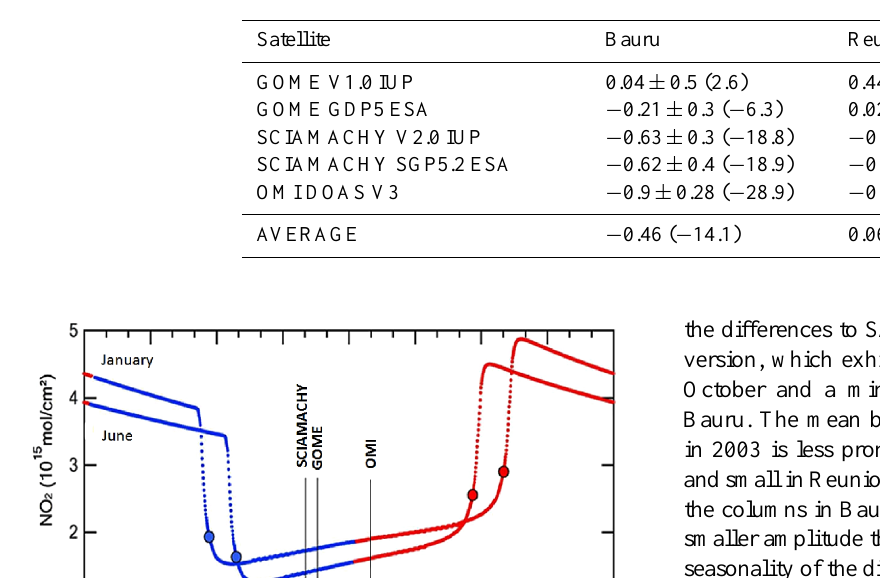
Figure 11. Monthly mean NO 2 time series of GOME GDP5 (green), GOME IUP V1 (blue), SCIAMACHY IUP V2 (red), SCIAMACHY SGP V5.02 (dark green), and OMI DOAS V3 (purple) total NO 2 over Bauru (top) and Reunion (bottom). Table 2. Mean biases and standard deviation in 10 15 moleculecm − 2 (%) between satellites and SAOZ NO 2 columns.